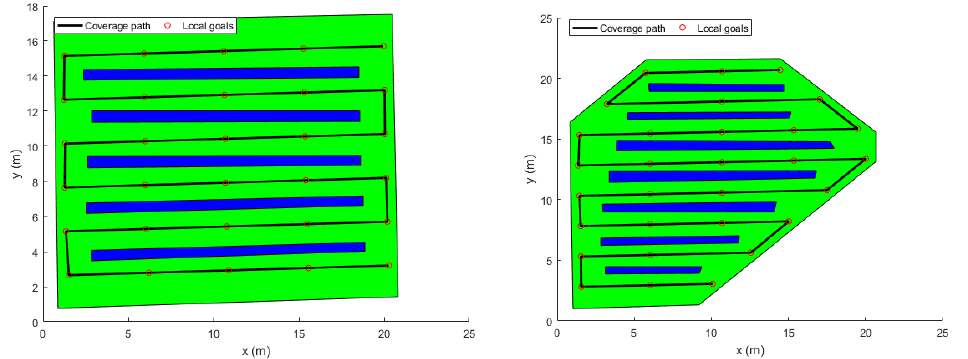
Figure 9. The generated coverage paths and way-points.